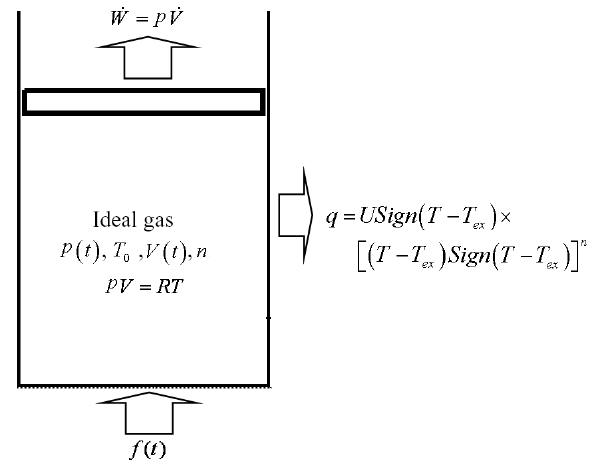
Figure 1. Schematic diagram of the model: a mole of ideal gas in a cylinder is pumped by a given heating function f ( t ) and is coupled to the heat bath.